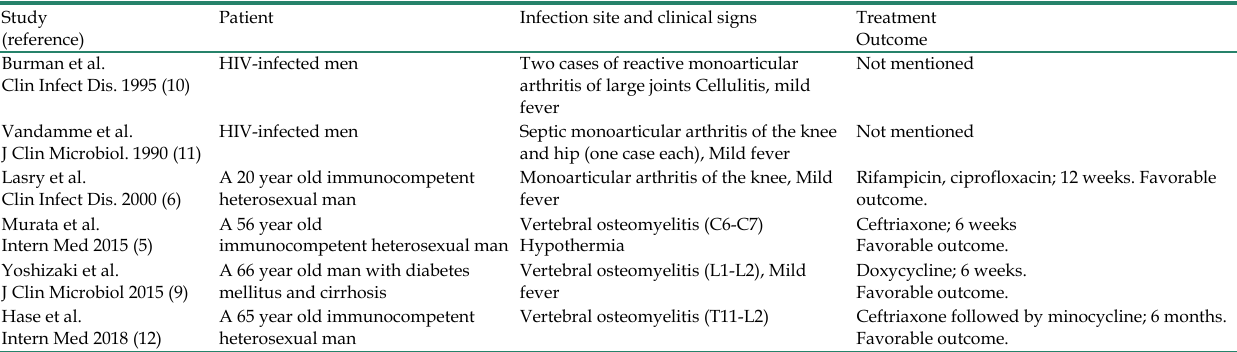
Table 1: Case reports of Helicobacter cinaedi bone and joint infections Study